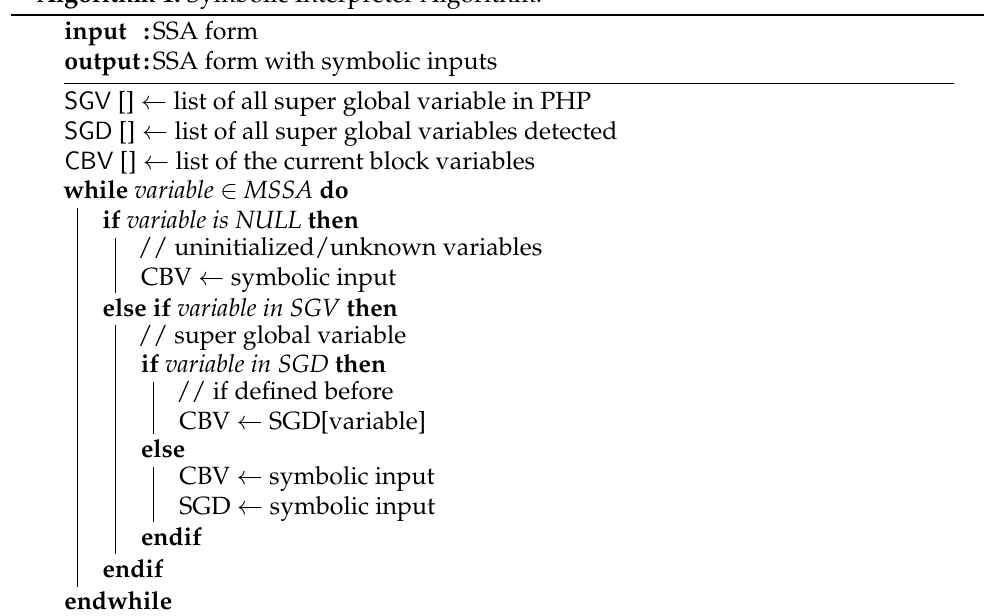
Algorithm 1: Symbolic Interpreter